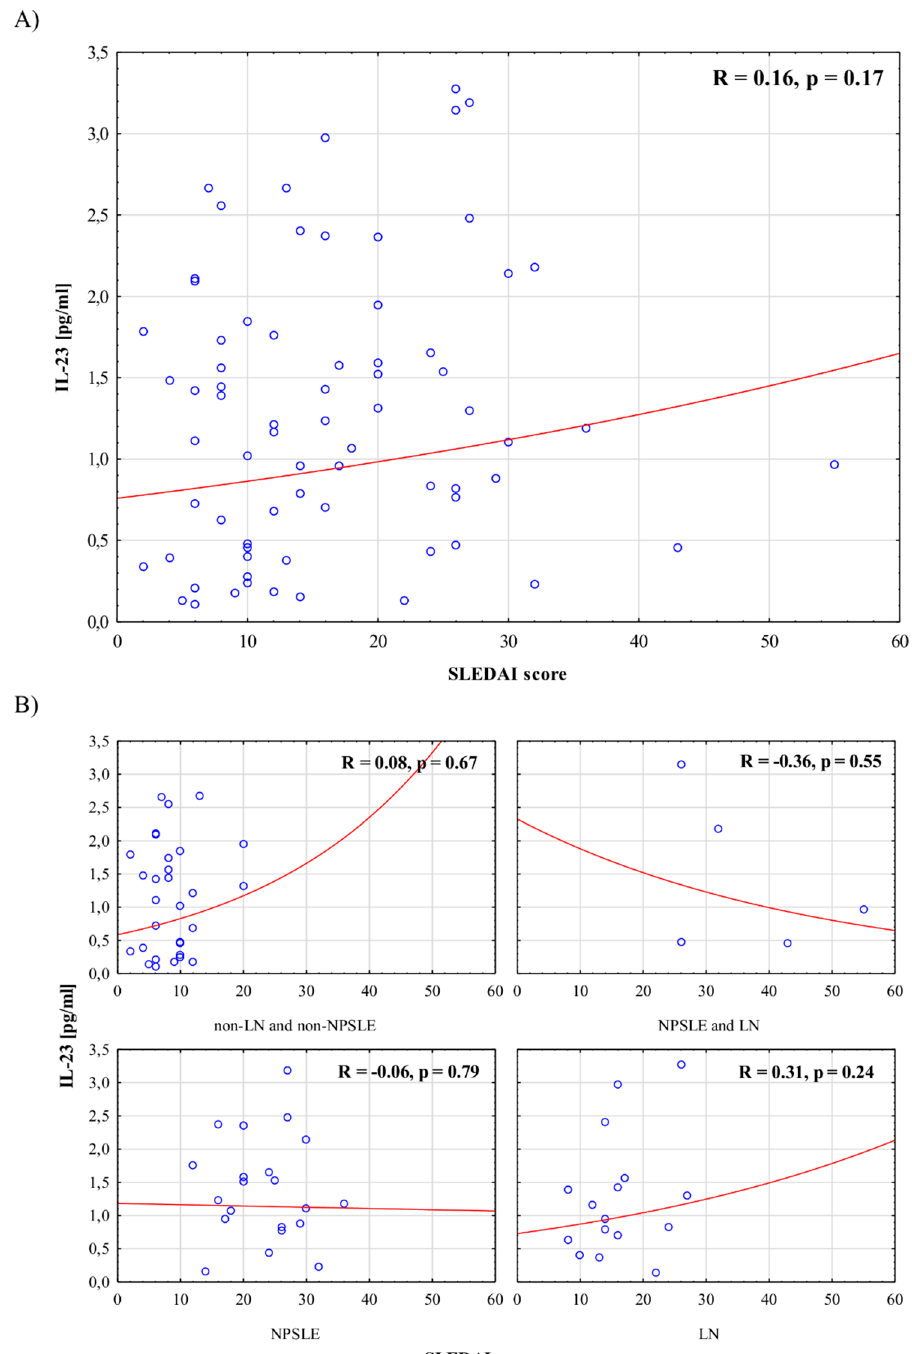
Figure 1. Association between serum IL-23 levels and disease activity in the whole group of patients ( A ), and in selected groups of patients ( B ).